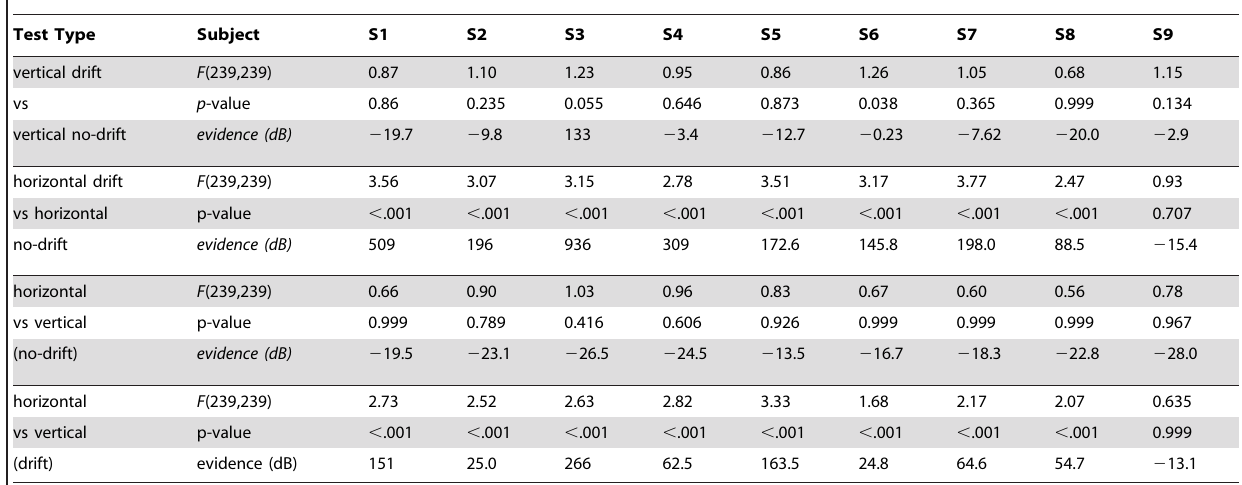
Table 1. Comparisons of endpoint